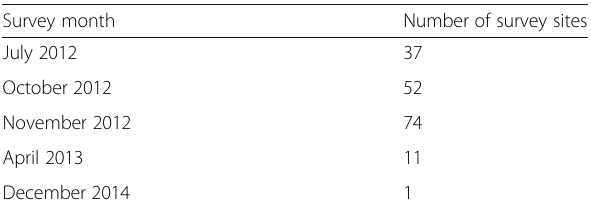
Table 1 List of survey dates and number of survey sites during each